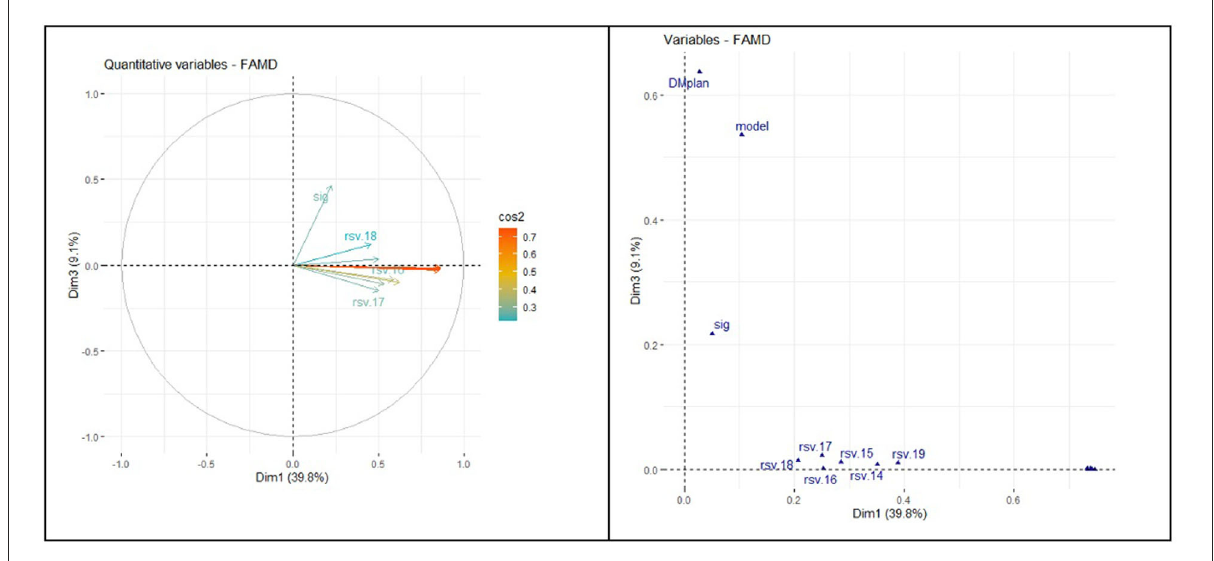
FIGURE6 Relationship between quantitative and qualitative variables (dimensions 1 and 3).